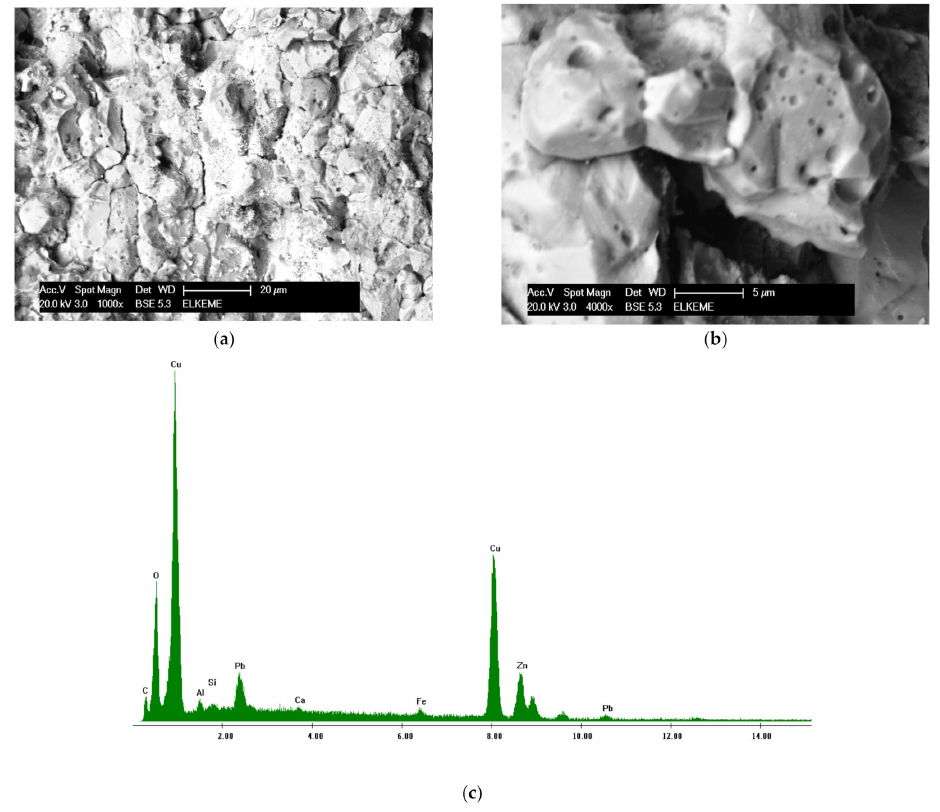
Figure 5. ( a , b ) Backscattered Electron (BSE) micrographs showing the fracture surface of a brass component showing intergranular morphology, ( c ) EDS spectrum of the fracture surface showing the presence of oxides. See Reference